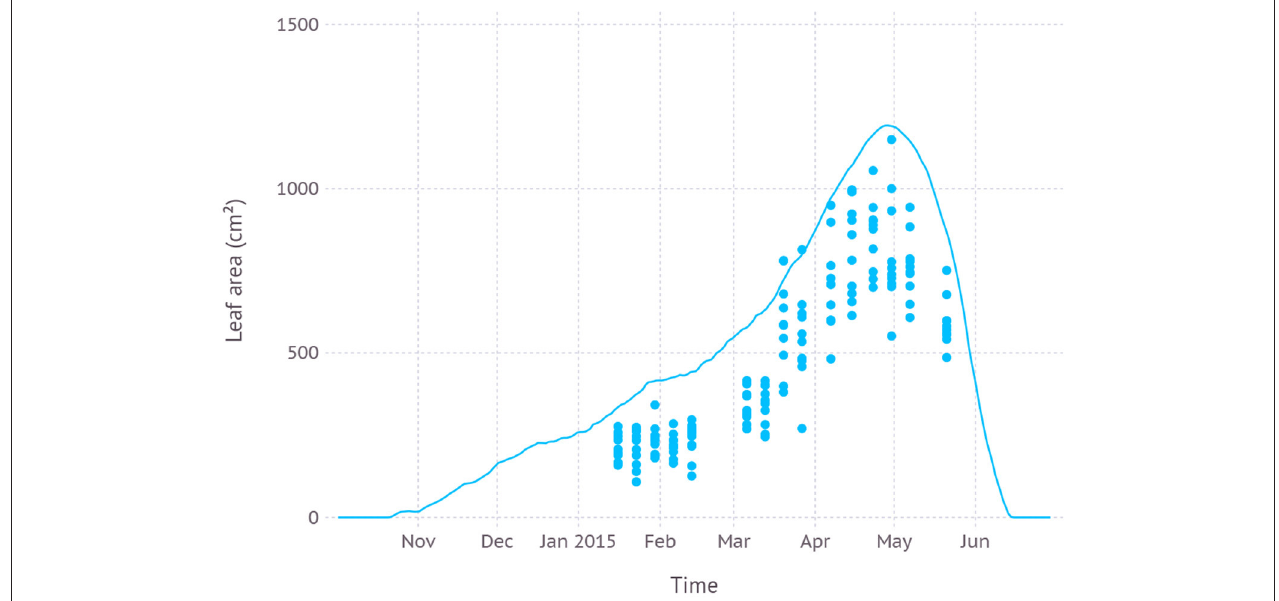
FIGURE 4 | Comparison of model simulated green leaf area and observation from dataset D1 which was from field measurements and primarily used for evaluating new parameters.